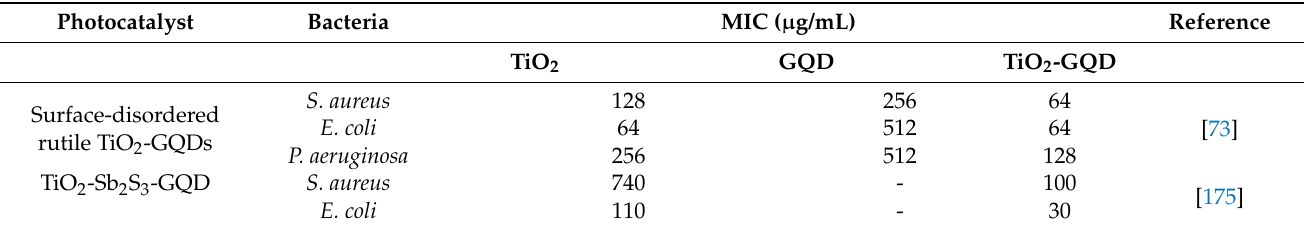
Table 5. TiO 2 /GQDs nanocomposites as antibacterial